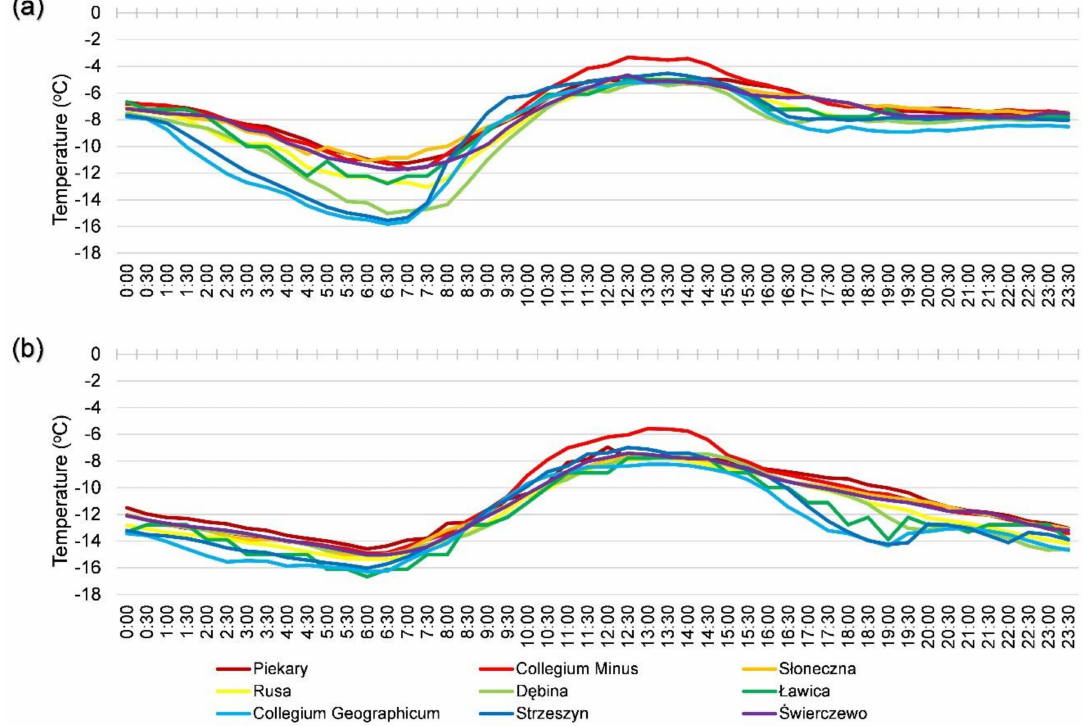
Figure 6. Daily course of air temperature in Pozna´n on 9 February 2010 ( a ) and 21 February 2011 ( b